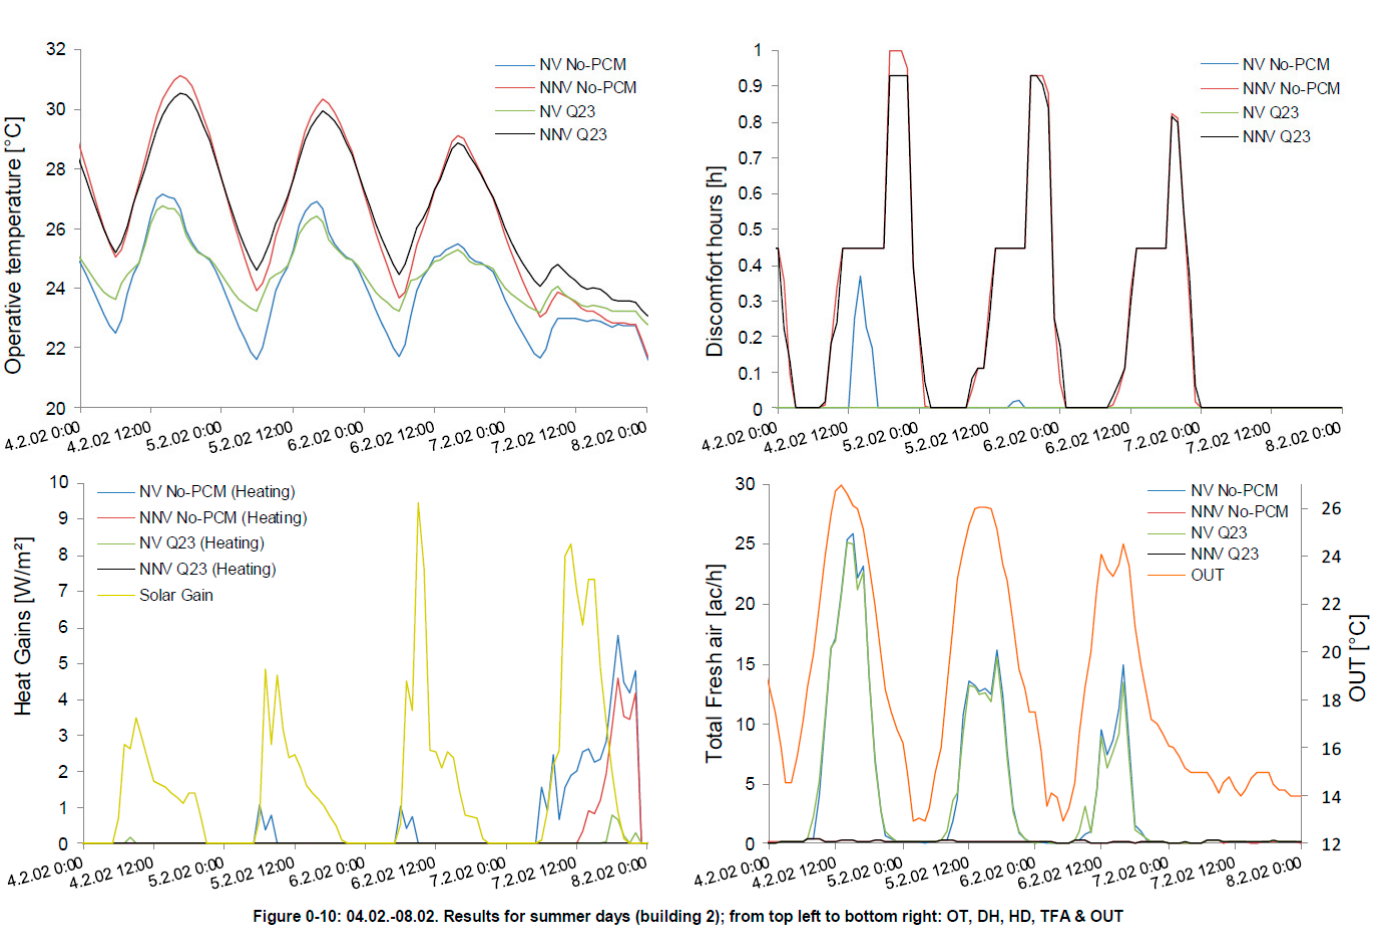
Figure 9. Operative temperature ( top left ), heat gains ( bottom left ), discomfort hours ( top right ), and total fresh air ( bottom right ) for 4–7 February (summer days) for building B.